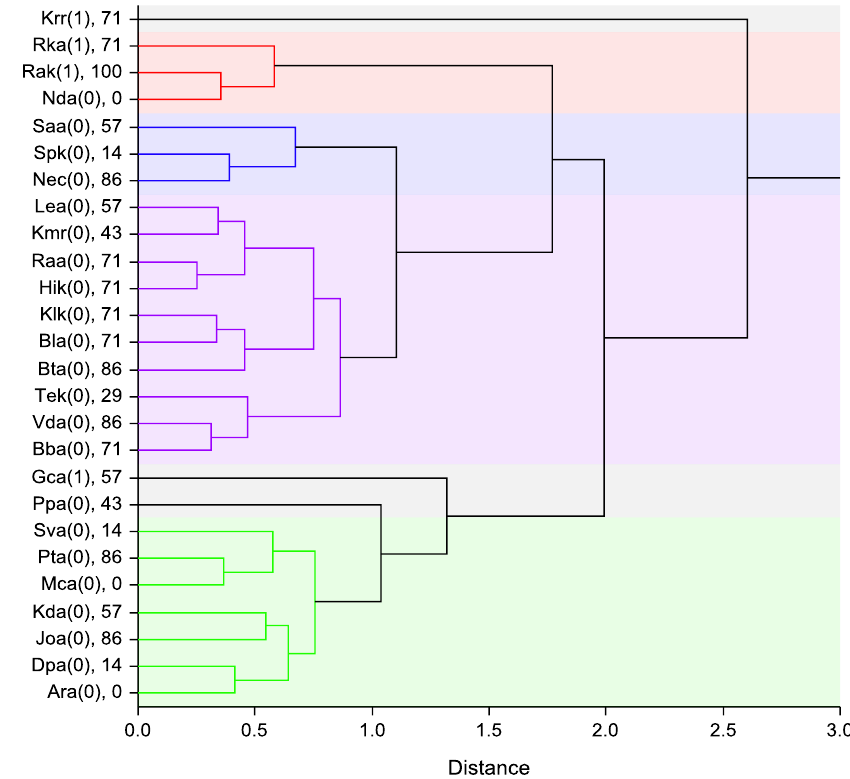
Fig. 3 Dendrogram of children with talent and percentage success. Notice: The axis “X“ displays the dissimilarity of an object (distance). A simple average grouping method is applied on variables selected by logistic regression: pv3, fs4,